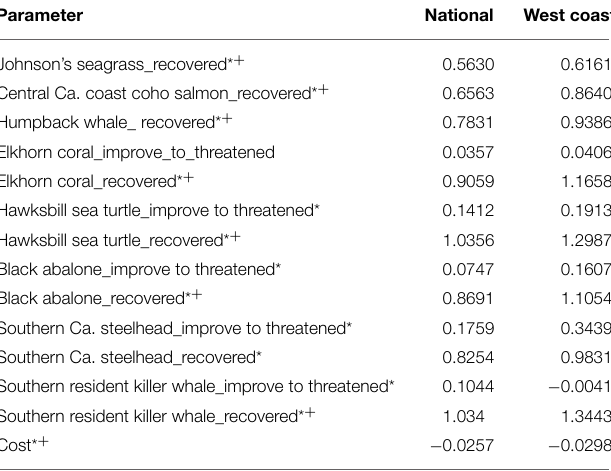
TABLE 5 | Parameter estimates from choice models.